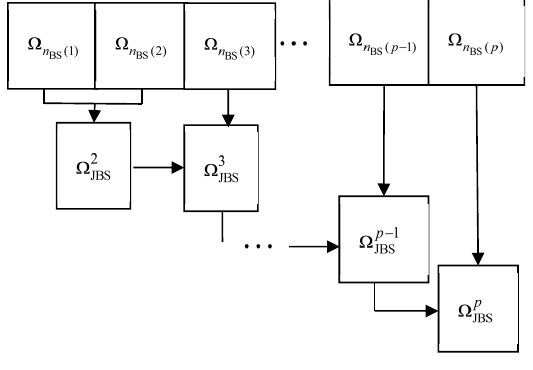
Figure 2. Diagram of progressive BSF.